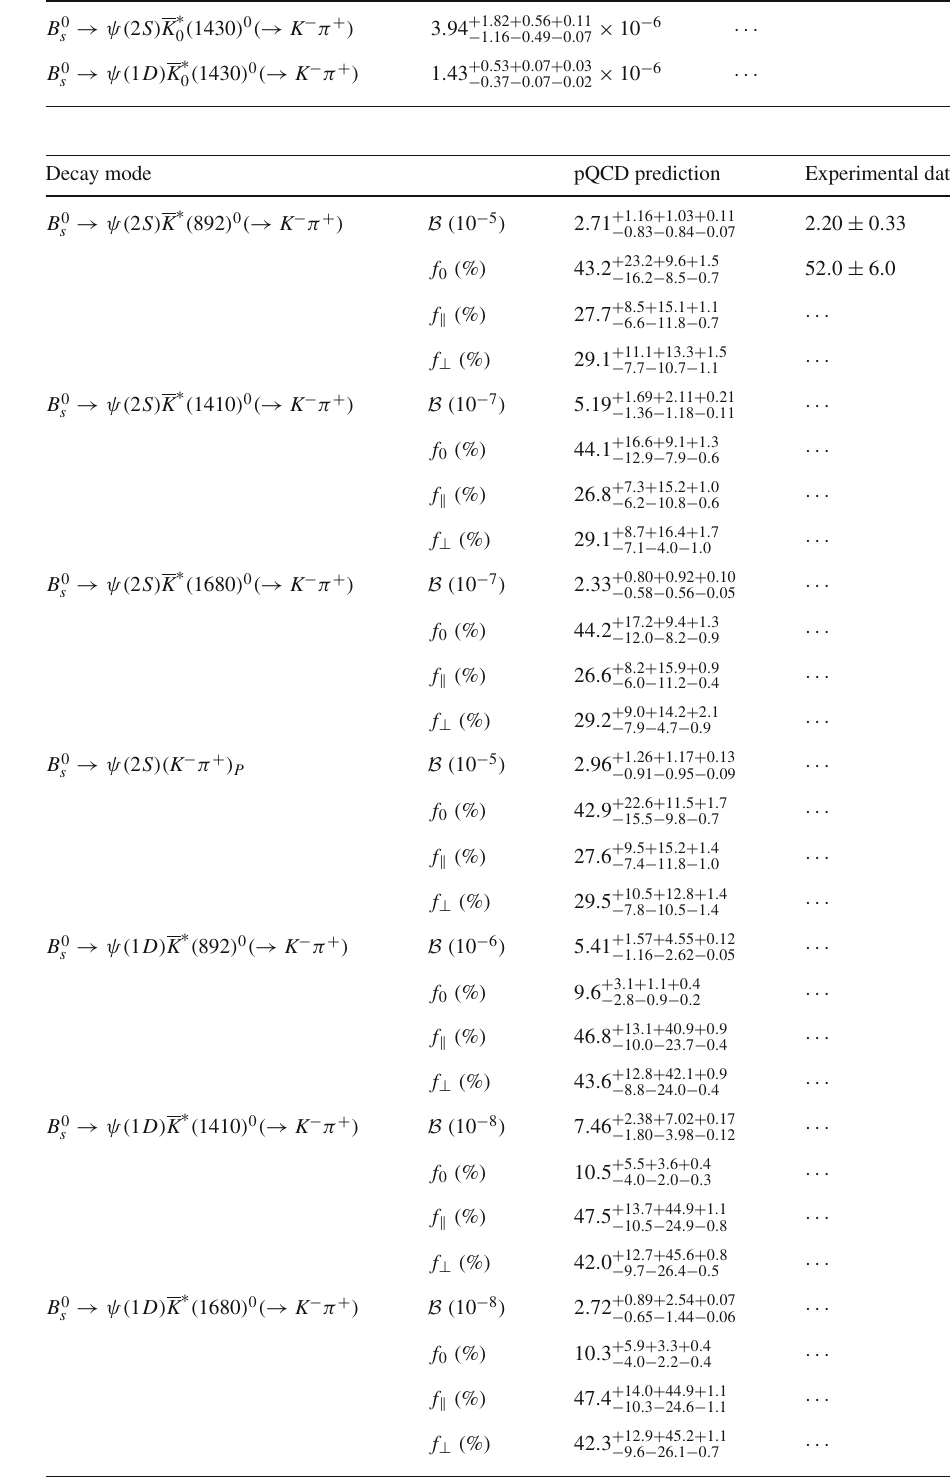
Table 3 Branching ratios of the S-wave resonance in the quasi-two-body decays B 0 s →